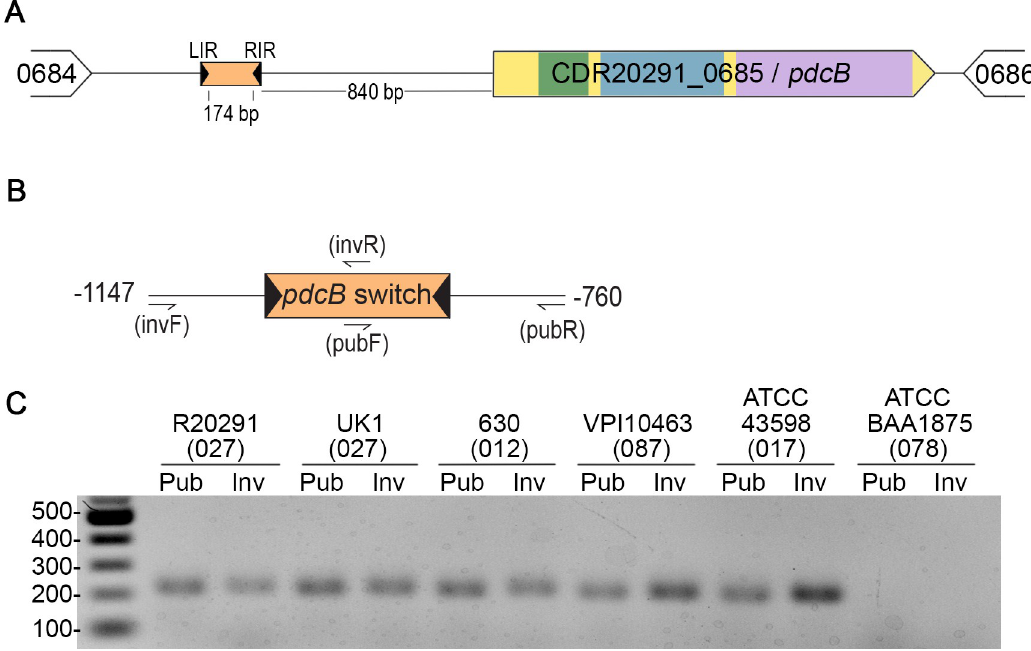
Fig 1. The pdcB switch (Cdi2) is invertible in C . difficile . (A) Diagram of the pdcB locus indicating the relative positions of the upstream invertible element (orange) and inverted repeats (black arrows). LIR–left inverted repeat, RIR–right inverted repeat. PdcB contains a PAS domain (green), a degenerate GGDEF domain (blue), and an EAL domain (purple). (B) Diagram of the OS-PCR strategy used in (C) to selectively amplify the orientation of the pdcB switch present in the published genome of R20291 (Pub) or the inverse (Inv) orientations. Primer positions are indicated by half-arrows, and the genomic region indicated (-1147 to -760) is relative to the predicted pdcB start codon. (C) OS-PCR for the pdcB switch in six different C . difficile strains, with the previously determined ribotype indicated in